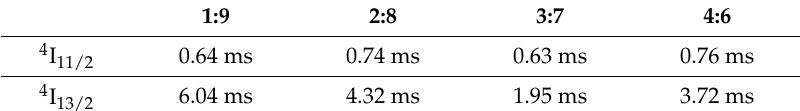
Table 3. Fluorescence lifetime of different proportions of Sc:Ga from 1:9 to 4:6.